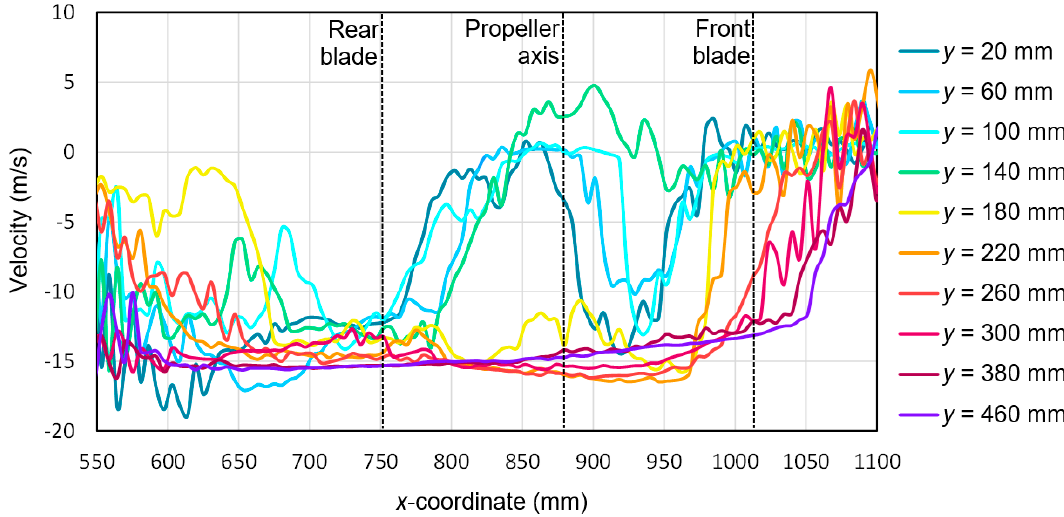
Figure 18. Horizontal components of the airflow velocities around the research object for the following configuration: angle of attack α = − 4° and airflow in the wind tunnel v wt = 12.5 m/s. The vertical component for the angle of attack α = − 4° with the airflow in the tunnel is shown in Figure 19. Similar to the horizontal component, at the beginning and end of the analyzed area, a